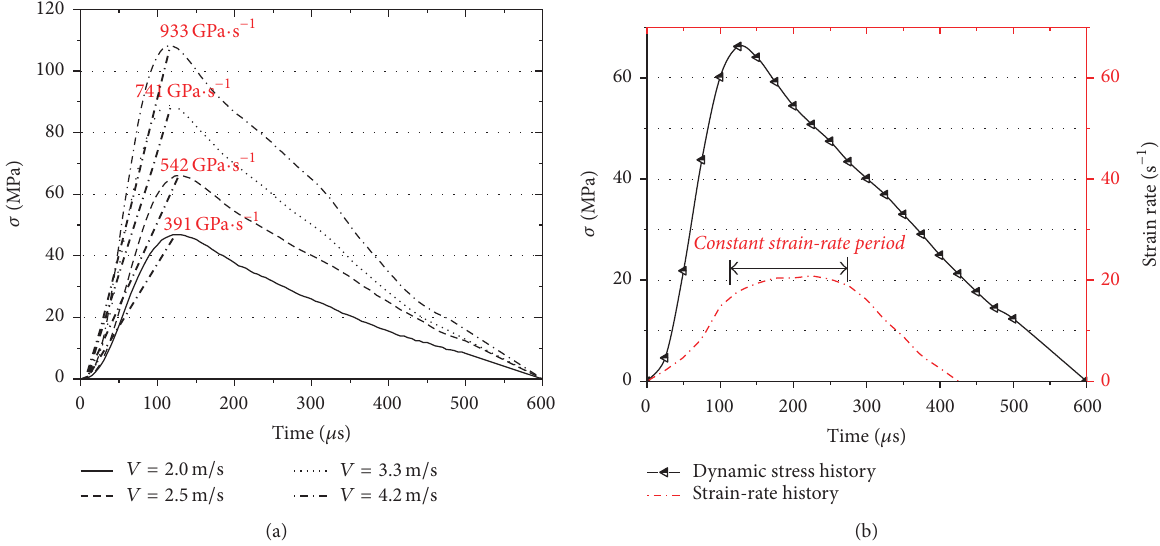
Figure 8: (a) Measured incident stress waves under different impact loadings and (b) complete strain-rate curve under certain velocities ( 𝑉 = 2.5 m/s). Table 3: Summary of dynamic tensile test results with different grain